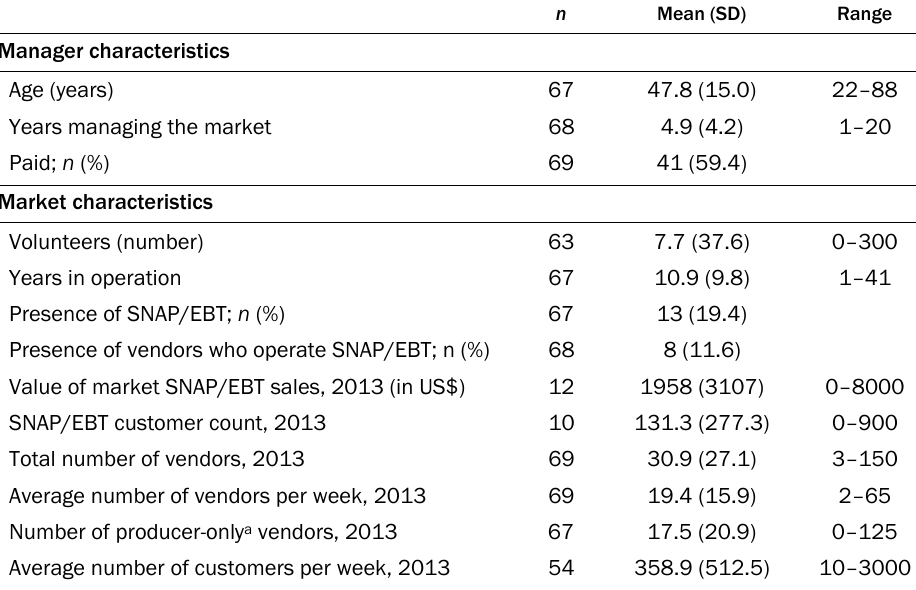
Table 2. Characteristics of North Carolina Farmers Market Managers and the Markets They Manage, n